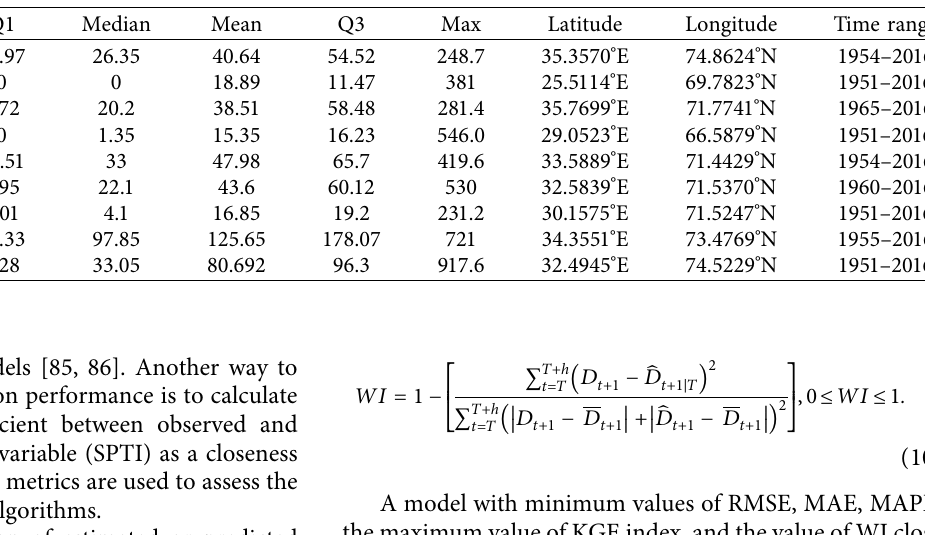
Table 2: Summary statistics of rainfall (in mm) and spatial characteristics of selected